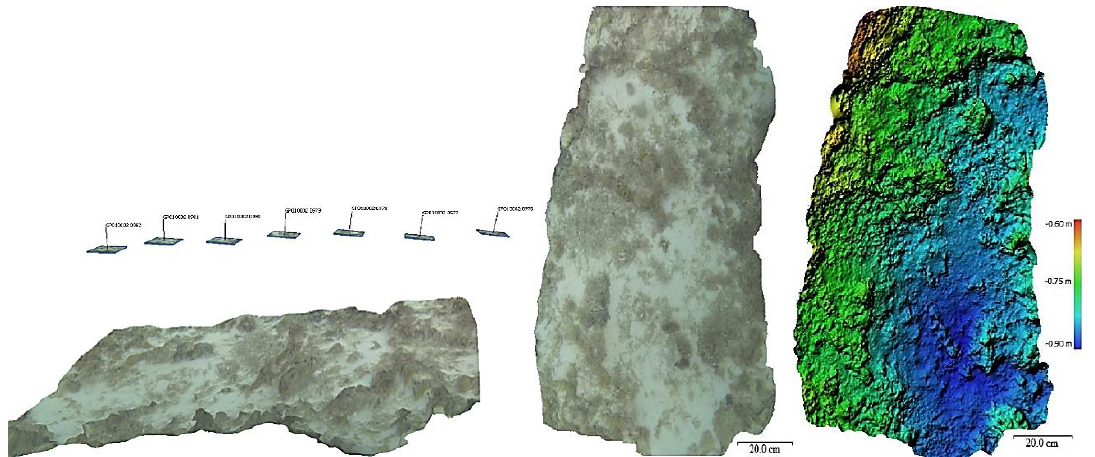
Sed = Sediments, SS = Soft Sand, and Seag = Seagrass.